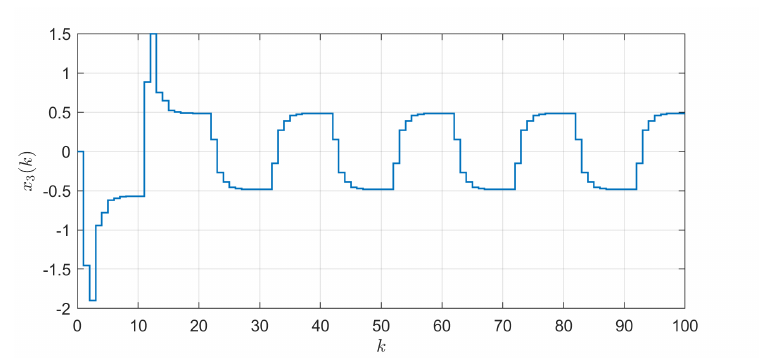
Figure 3. Second state variable.